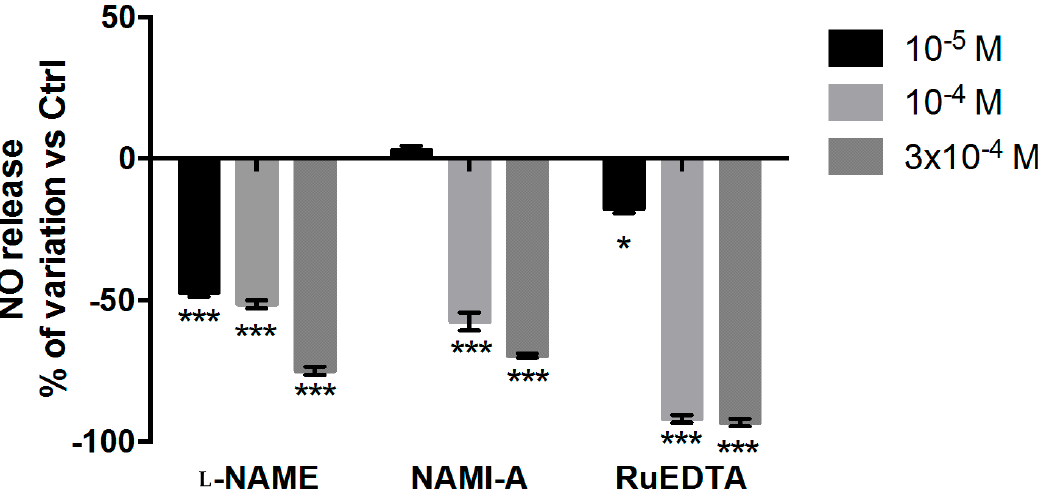
Figure 2. Effects of ruthenium compounds on the NO production by macrophages. Murine peritoneal macrophages were treated for 24 h with 10 μ g/mL LPS and contemporary with 10 − 5 , 10 − 4 , and 3 × 10 − 4 M of N ω -nitro- L -arginine methyl ester hydrochloride ( L -NAME), imidazolium trans -imidazoledimethylsulfoxidetetrachloro-ruthenate (NAMI-A), and potassiumchlorido (ethylendiamminotetraacetate)rutenate(III) (RuEDTA). NO release in the extracellular medium was measured by the Griess test. Data are expressed as per cent of variation vs. the controls and are the mean ± S.E.M. of five samples per group. ANOVA and Tukey–Kramer: * p < 0.05, *** p < 0.001 vs. Control.